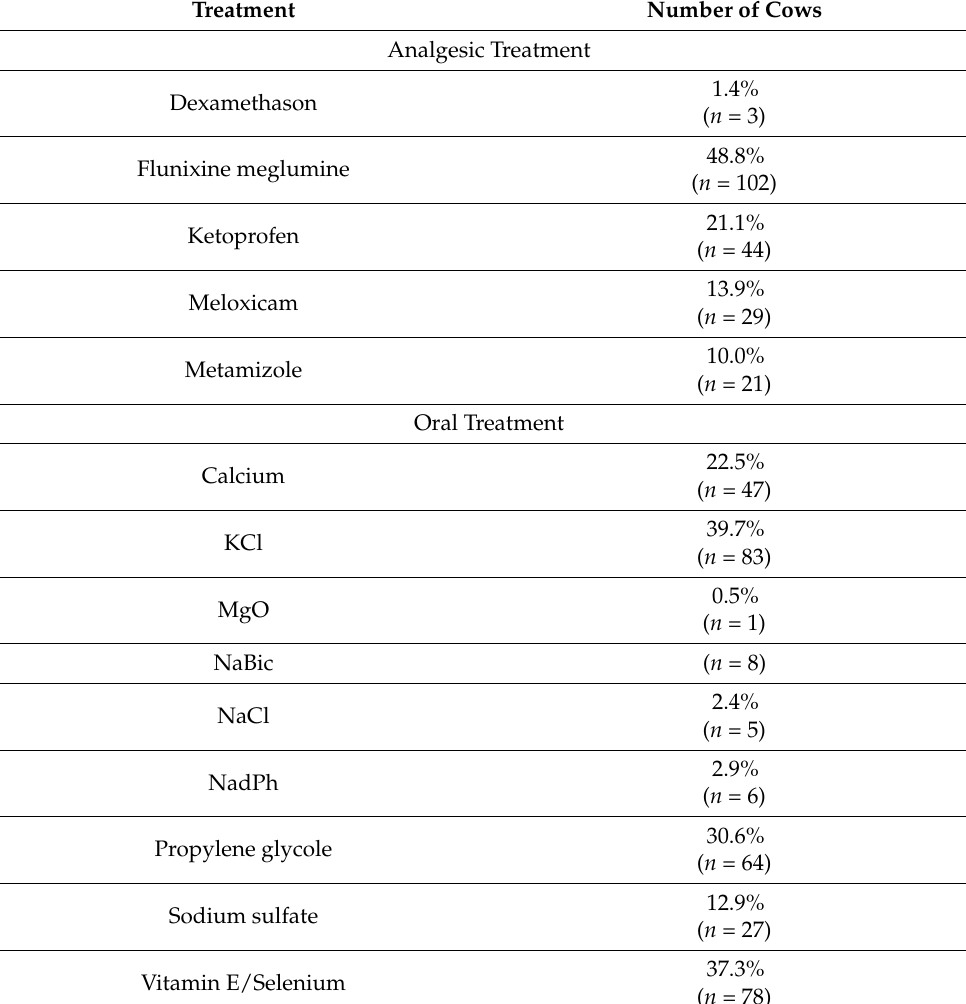
Table 1. Distribution of analgesic and oral treatment (oral drench) in 209 cows with left displacement of the abomasum (LDA). Following abomasal rolling as conservative treatment, 79.0% ( n = 165) and 8.1% ( n = 17) of the cows were treated with either one or two analgesic drugs, and 45% ( n = 95) of the cows received an oral drench. The composition of the oral drench varied and could include calcium, potassium chloride (KCl), magnesium oxide (MgO), sodium chloride (NaCl), soidumhy- drogencarbonat (NaBic), sodiumhydrogenphosphate (NadPh), propylene glycole, sodium sulfate, and/or vitamin E/selenium. Treatment Number of Cows Analgesic